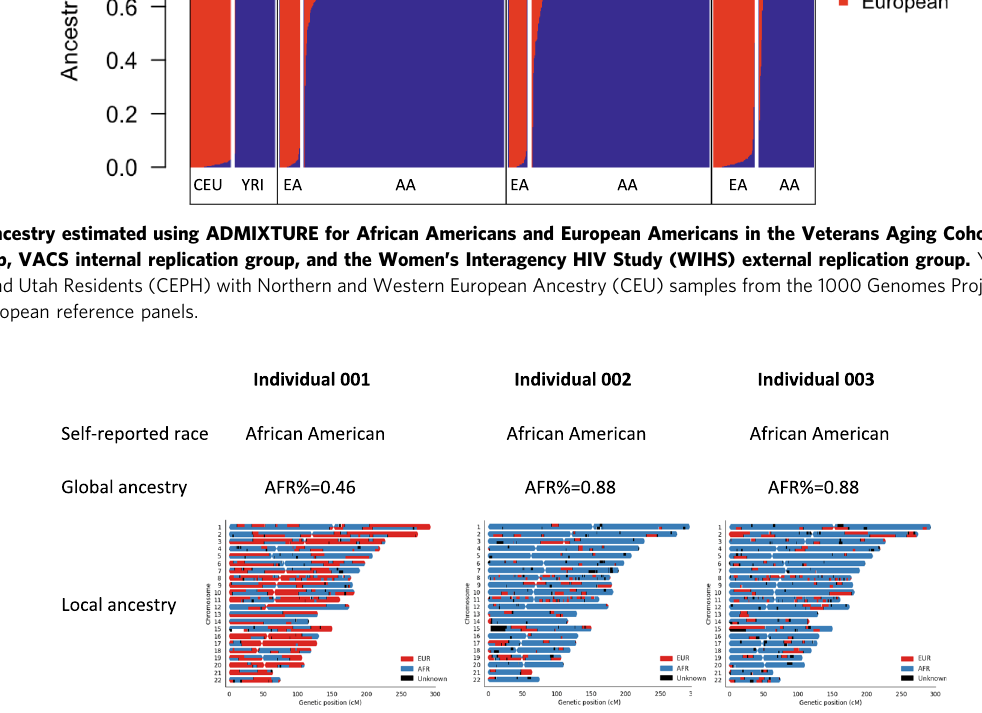
Fig. 2 Self-reported race, global ancestry, and local ancestry across 22 chromosomes for 3 self-reported African Americans in the Veterans Aging Cohort Study cohort. Race was extracted from self-reported survey data. Global ancestry was estimated using ADMIXTURE. Local ancestry was estimated using RFMix. The horizontal axis represents genomic coordinates in centimorgans and the vertical axis represents 22 chromosomes, each has two strands, and the color indicates local ancestry designation inferred from RFMix. Yoruba in Ibadan, Nigeria (YRI) and Utah Residents (CEPH) with Northern and Western European Ancestry (CEU) samples from the 1000 Genomes Project are used as the African and European reference panels for global and local ancestry